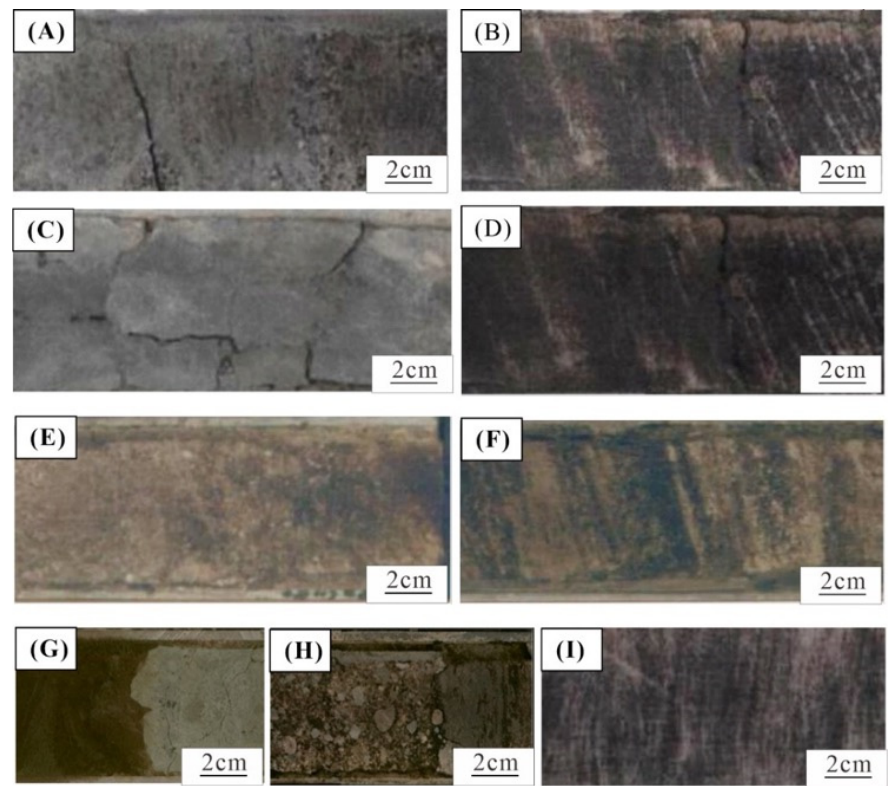
Figure 8. ( A ) PL19 − 3 − F, 1127.8 m, BC, Gray medium sandstone. ( B ) PL19 − 3 − F, 1190.4 m, BC, Cross − bedding. ( C ) PL19 − 3 − E, 1190.1 m, DB, Gray fine sandstone. ( D ) PL19 − 3 − F, 1190.43 m,